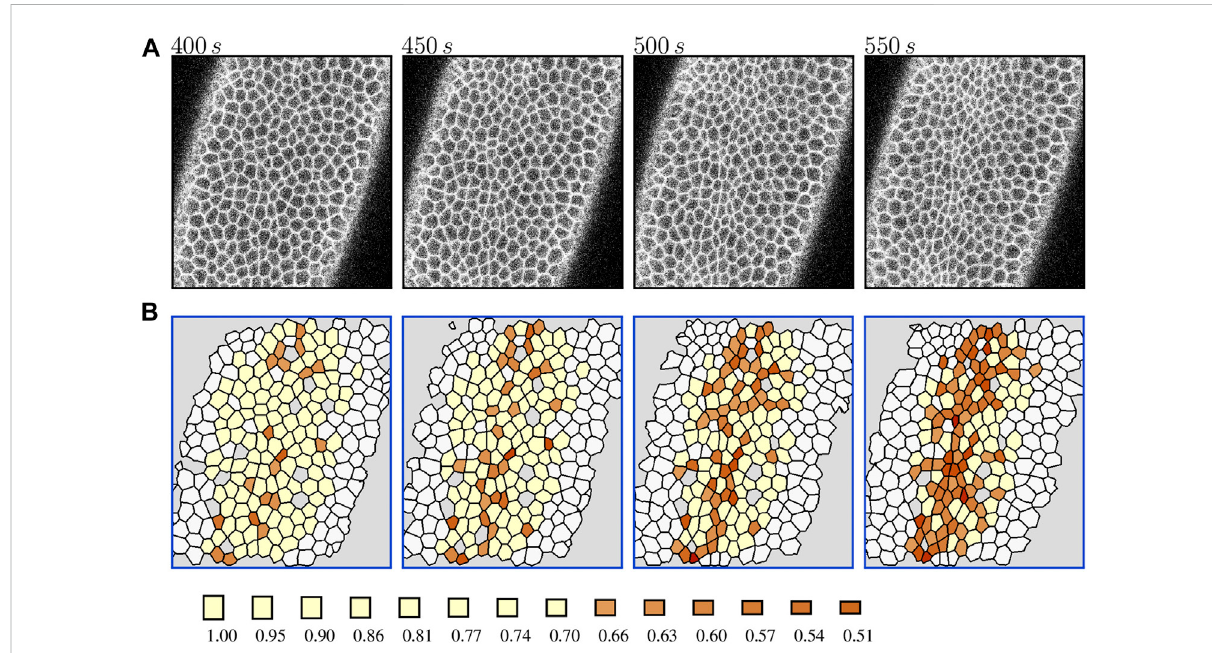
FIGURE 2 Formationofcellularconstrictionchains(CCCs)inthe Drosophila embryoduringthelateslowphaseofVFF. (A) Theoriginalcontrast-enhanced time-lapseimagesoftheventralsideofaliveSpider-GFP Drosophila embryo. (B) Thecorrespondingprocessedimageswithtrackedcellscoloredby thevalueofareareductionfactor r A .ThelabelingisthesameasinFigure1,exceptthatthecolorscaleistruncatedtovisualizetheformationofchains ofstronglyconstrictedapices( r A ≤ 0.66).TheresultsforEmbryo2.Liveembryoimageswereacquiredpreviously[2]andareusedhereunderthe article ’ s CC BY